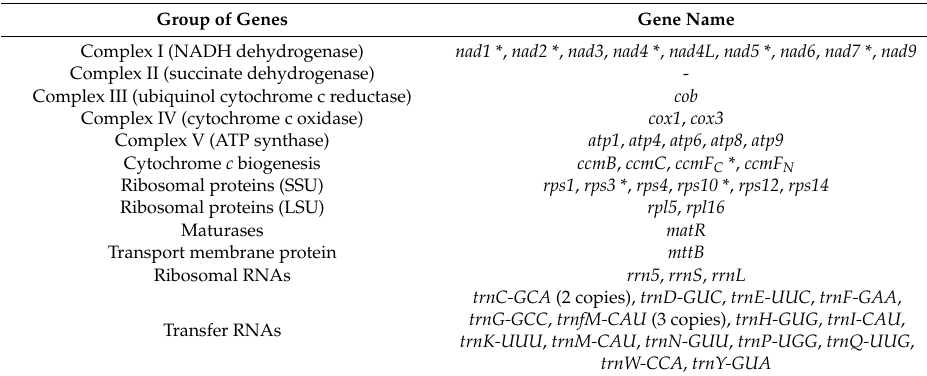
Table 2. Gene content of P. vulgaris mitogenome.